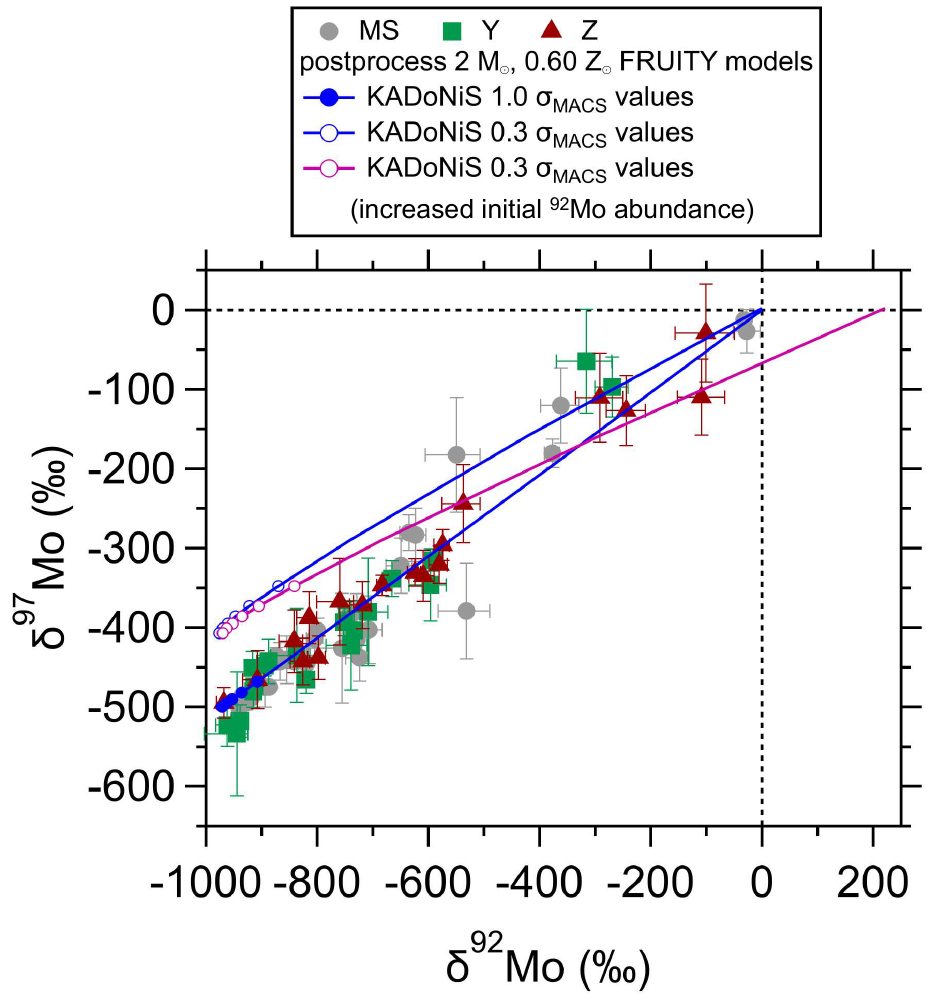
Figure 6. Mo 3-isotope plot comparing MS, Y, and Z grain data [47,66] with the same FRUITY model Figure 6. Molybdenum 3-isotope plot comparing MS, Y, and Z grain data [48,67] with the same but calculated with different Mo σ MACS values and different initial 92 Mo abundances. The FRUITY model but calculated with different Mo σ MACS values and different initial 92 Mo normalization isotope is 96 Mo. Note that the FRUITY models were run in a postprocess way (see [47] for details), different from the fully coupled FRUITY models shown in Figures 4 and 5. Error bars are all 1σ.